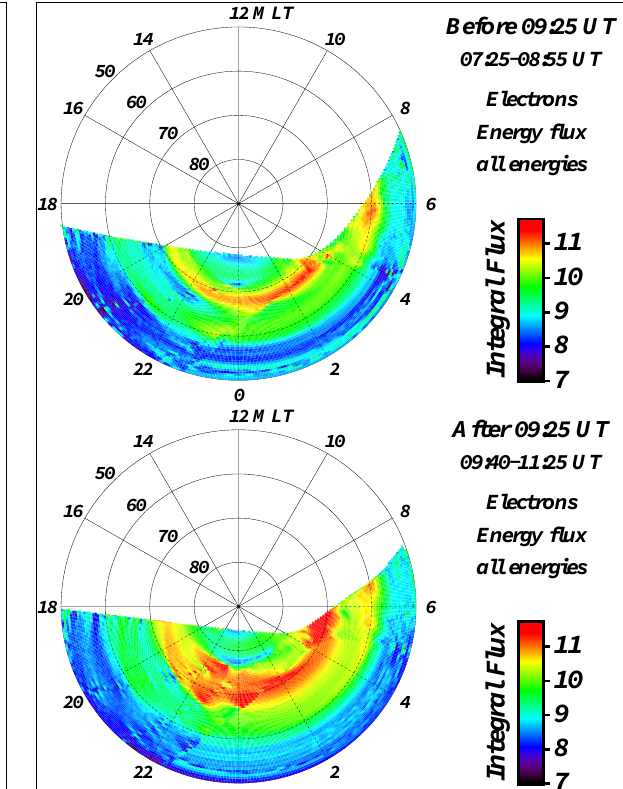
orbit is shown in the inset to the right of the electron